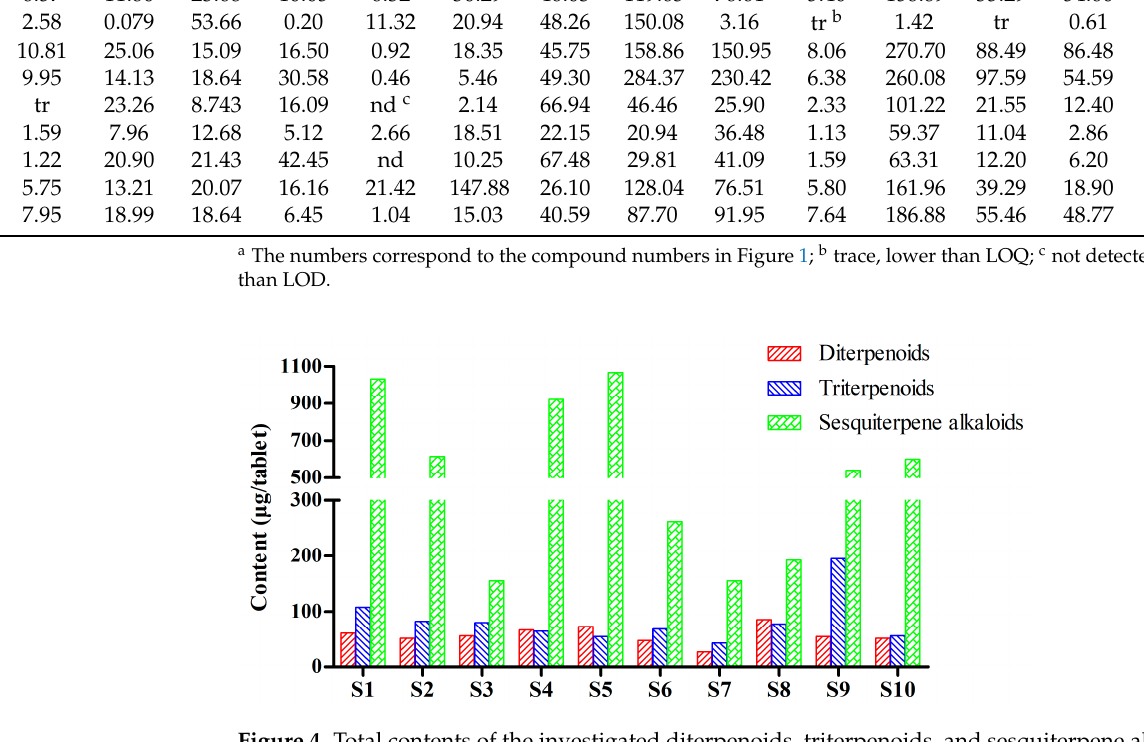
Figure 4. Total contents of the investigated diterpenoids, triterpenoids, and sesquiterpene alkaloids in TGTs from different manufacturers.